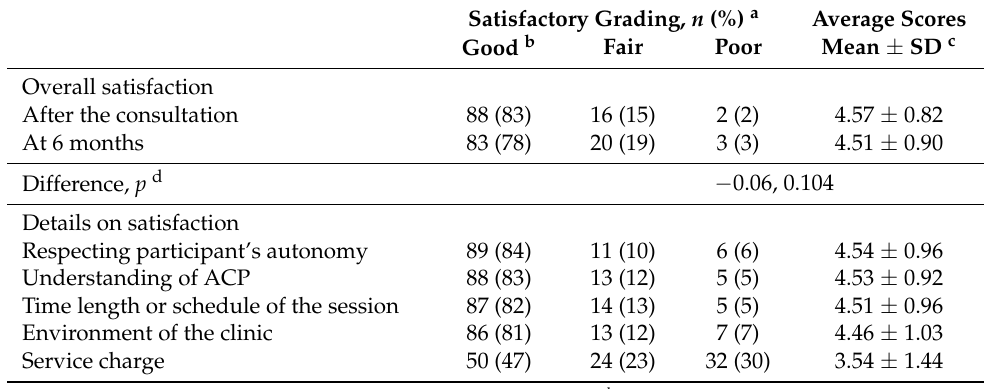
Table 5. Satisfactory